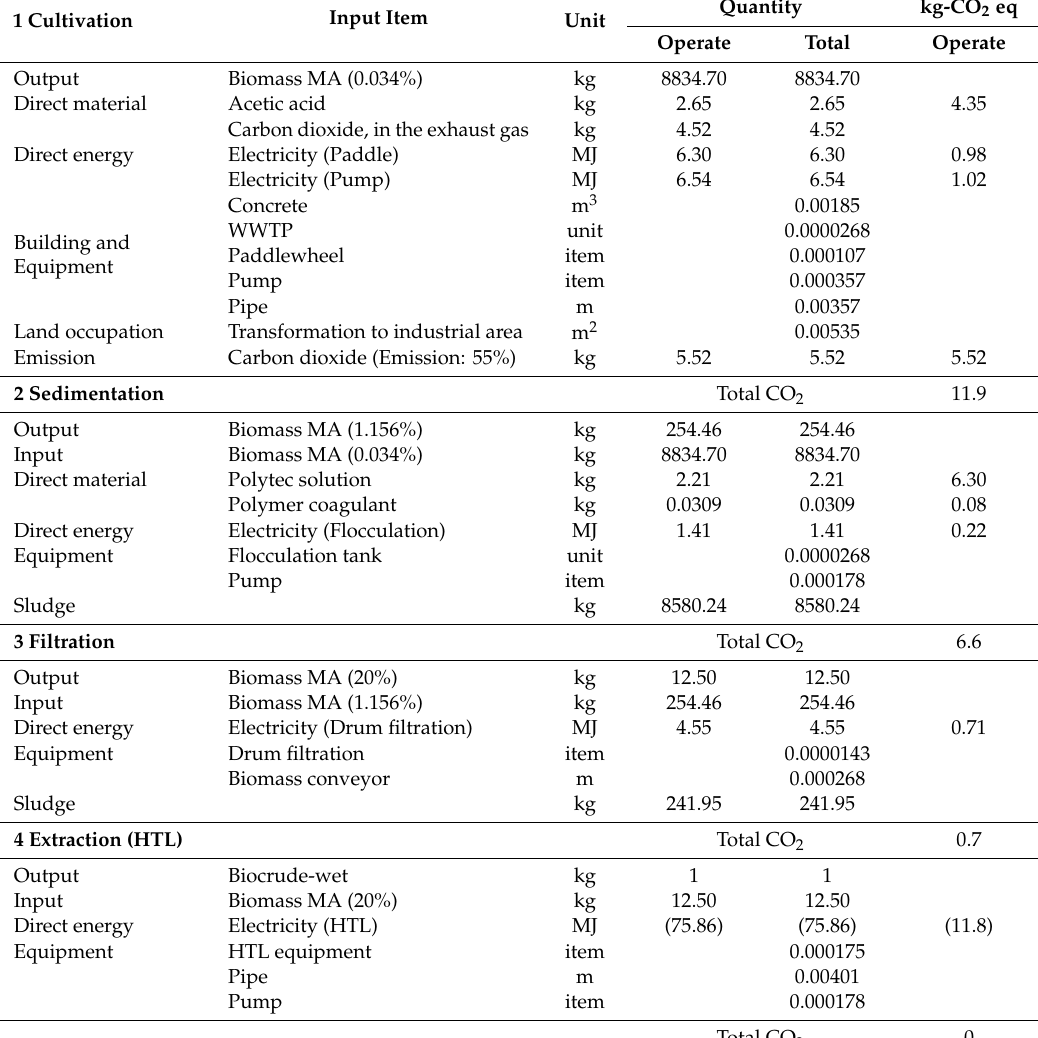
Table A4. Input and output data used in the simulation process using SimaPro ® (Per 1 kg-biocrude-wet from 8.8 m 3 -w.w.).